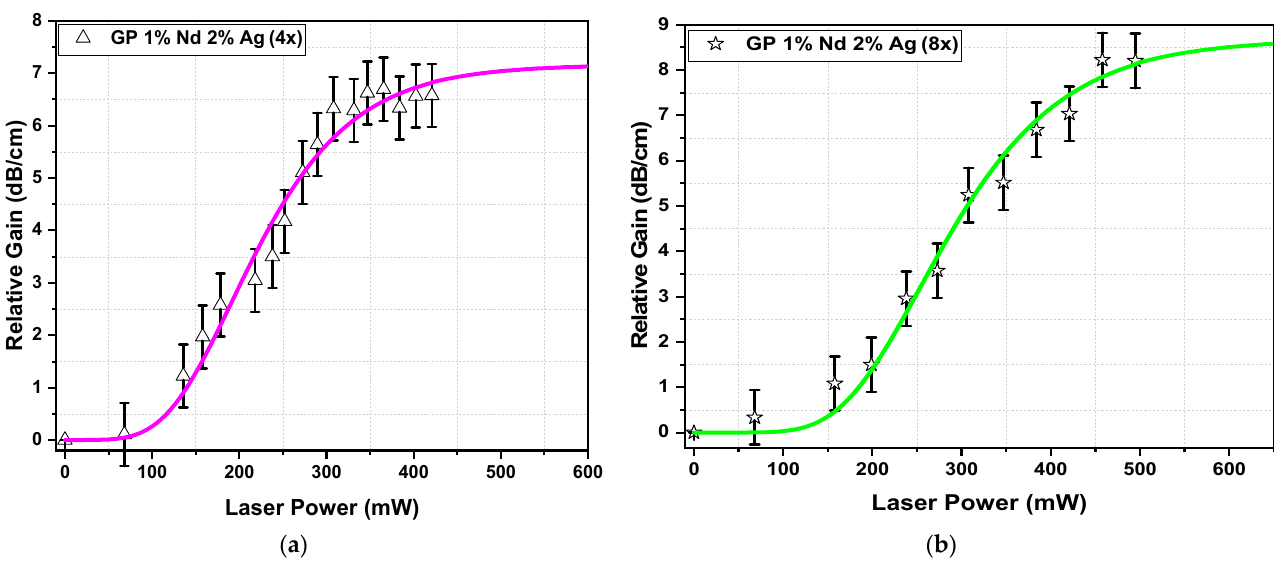
Figure 7. Relative gain (signal enhancement) at 1064 nm as a function of pump power at 808 nm, for 400 nW of input signal power, for the double waveguides written in Nd 3+ -doped GeO 2 -PbO with Ag NPs with ( a ) 4 and ( b ) 8 superimposed lines.